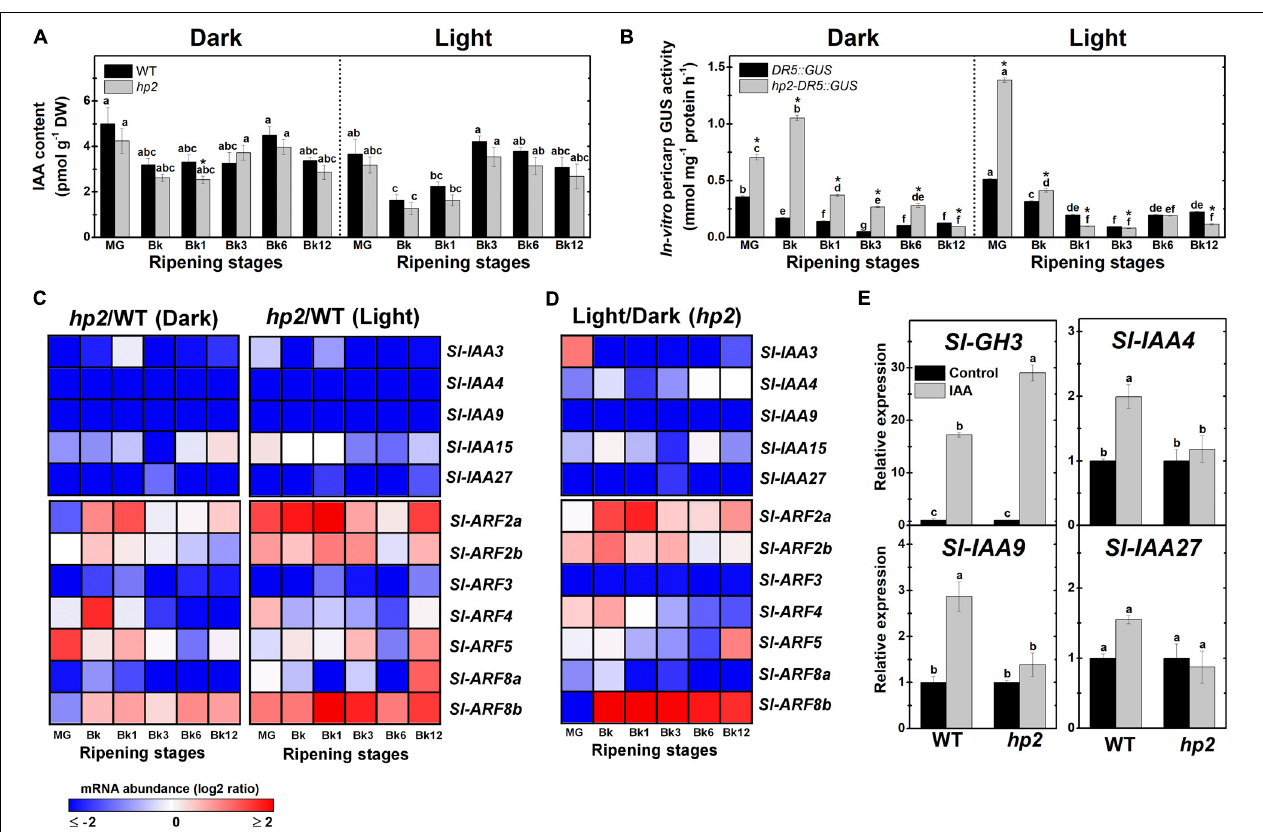
FIGURE 5 | Light-hypersensitivity promotes auxin sensitivity and signaling without altering endogenous IAA levels. Treatment details as described in Figure 1 . (A) Endogenous indole-3-acetic acid (IAA) levels in wild-type (WT) and high pigment-2 ( hp2 ) fruits. (B) In vitro GUS activity assayed in WT and hp2 fruits carrying the auxin-responsive promoter DR5 fused to the GUS reporter protein ( DR5::GUS and hp2 - DR5::GUS ). (C) Heatmap representation of the differences in mRNA levels of auxin signaling genes between the WT and hp2 fruits ripened under light or dark conditions. (D) Heatmap representing differences in mRNA levels of auxin signaling genes between light and dark samples of hp2 fruits at each sampling time. The relative transcript values are presented in Supplementary Figures 7 , 8 . (E) Relative mRNA levels of auxin-responsive genes in WT and hp2 fruits treated with 100 µ M IAA for 6 h. Data are means ( ± SE) of at least three biological replicates. Different letters indicate statistically significant differences (Tukey’s test, p < 0.05) within each genotype (in A,B ) or among all data (in E ). In (A,B) , asterisks indicate statistically significant differences (Student’s t -test, p < 0.05) between genotypes. MG, mature green; Bk, Breaker; Aux/IAA, auxin/indole-3-acetic acid; ARF, auxin response